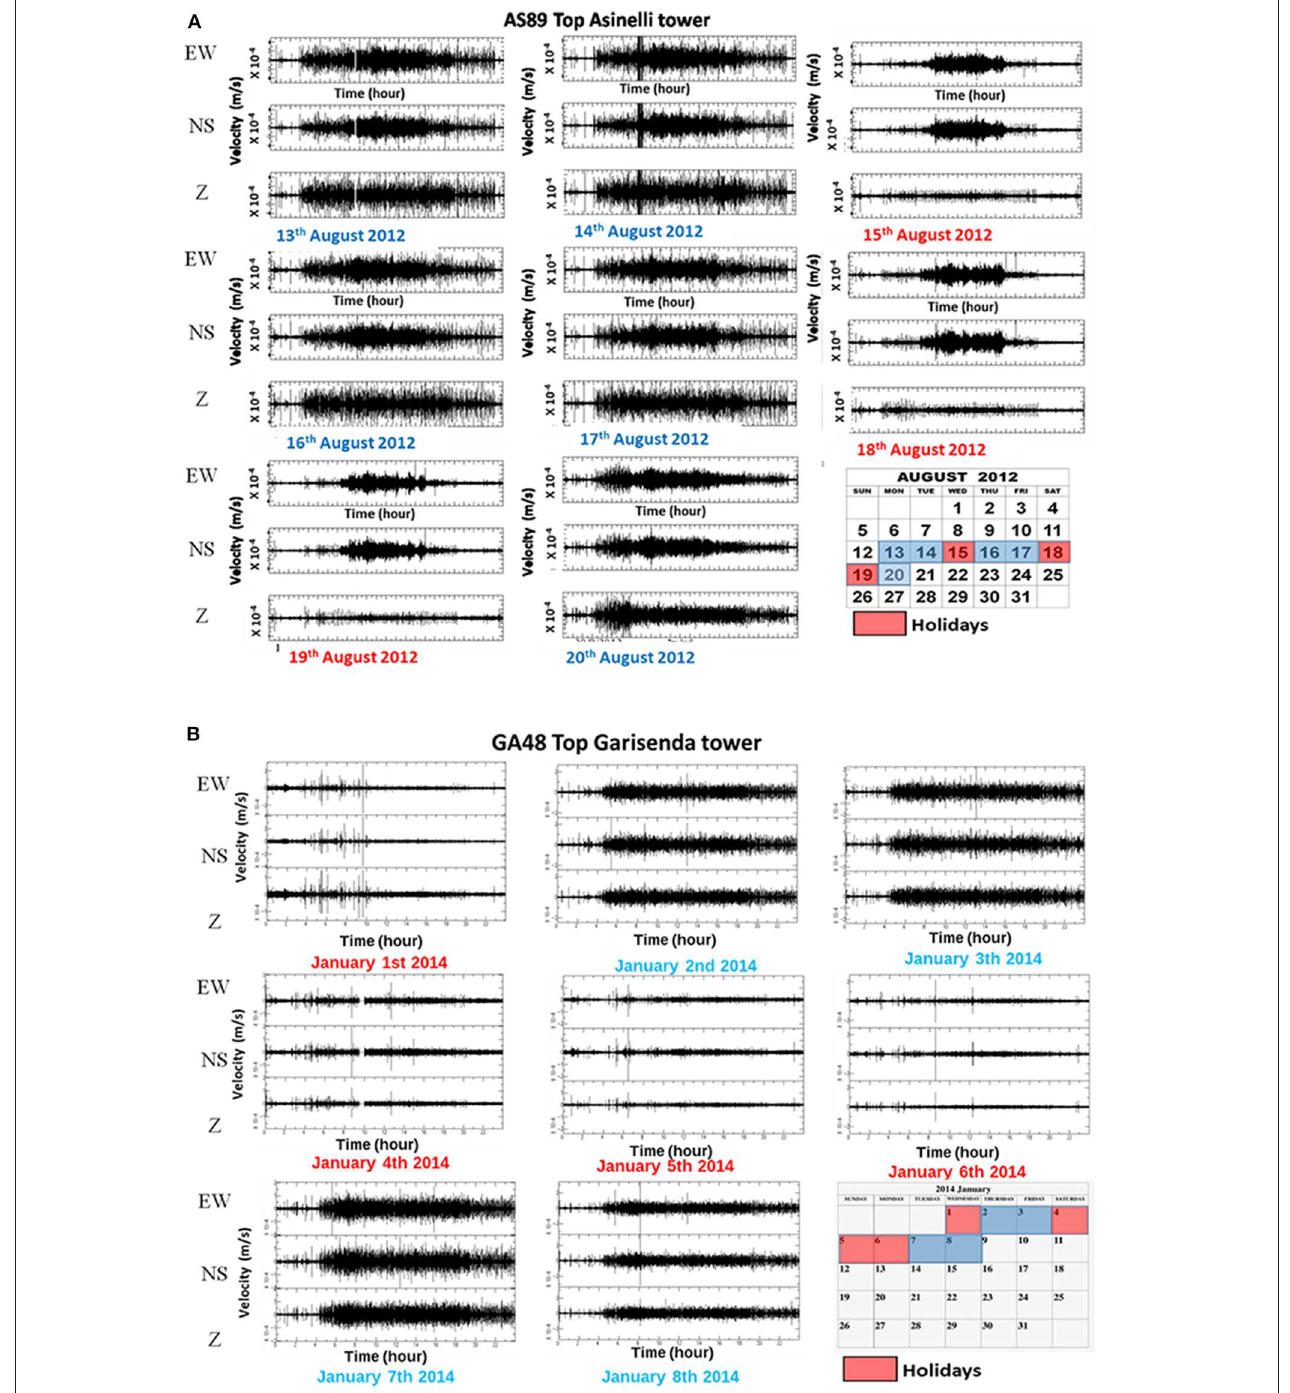
FIGURE 8 | Daily trend of the oscillation recorded by the top station of: (A) The Asinelli Tower from 13th to 20th August 2012; (B) the Garisenda Tower from 1th to 8th January 2014. The signal has been filtered in the 1–20Hz frequency band, in order to point out the content associated with the anthropic noise surrounding the Tower.